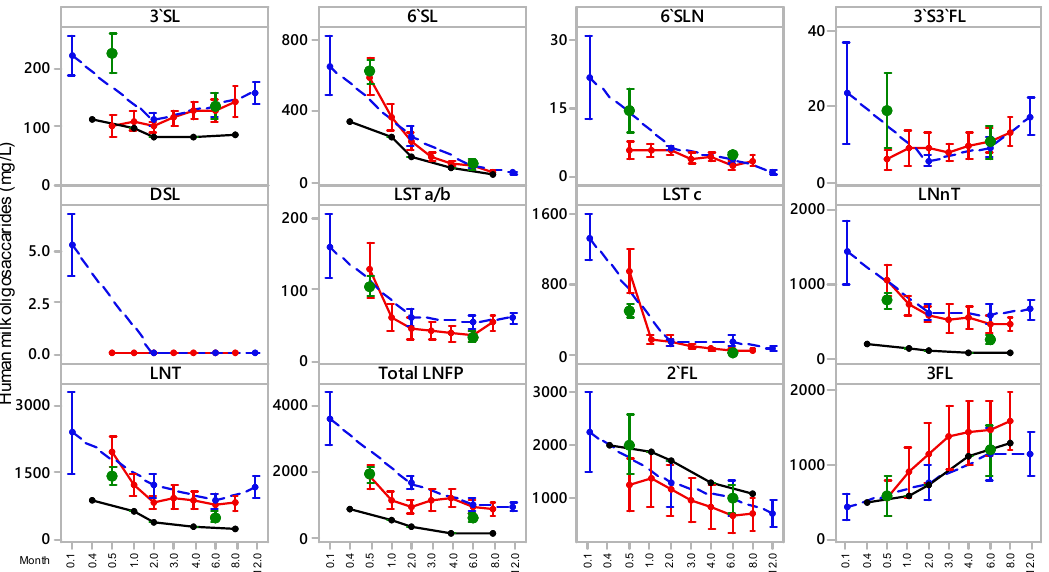
Figure 1. Human milk oligosaccharide (HMO) concentrations in the United Arab Emirates (UAE) mothers’ milk ( (cid:8) ) across the transitional milk and mature milk periods, plotted against the lactational trend reported by Ma et al. [30] for a Chinese cohort ( (cid:8) ) and Malaysian cohort ( (cid:8) ), and by Austin et al. [29] for a Chinese cohort ( (cid:8) ). 3’SL, 3’-sialyllactose; 6’SL, 6’-sialyllactose; 6’SLN, 6’-sialyllactosamine; DSL, disialyllactose; 3’S3FL, 3’-sialyl-3-fucosyllactose; LSTa / b, LS-tetrasaccharide a / b; LSTc, LS-tetrasaccharide; LNnT, lacto-N-neotetraose; LNT, lacto-N-tetraose LNFP, lacto-N-fucopentaose I; 2’FL, 2’-fucosyllactose; 3FL, 3-fucosyllactose.